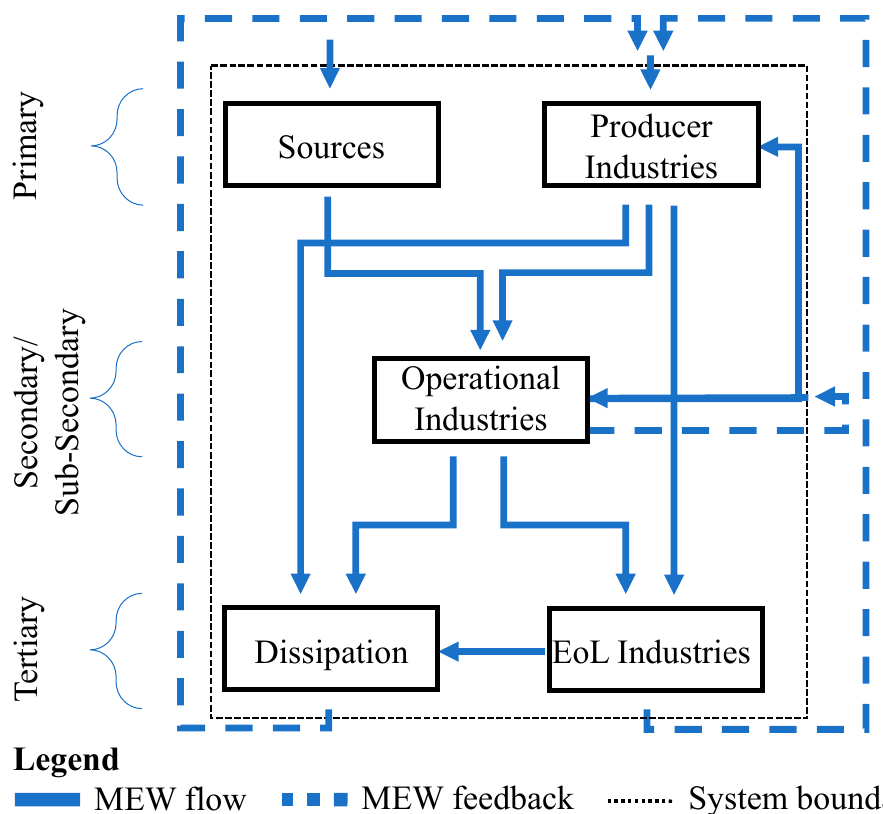
Figure 1. Network approach for the MEW interactions over the lifetime of PV technology. Three tiers in the life cycle include primary, secondary/sub-secondary, and tertiary, representing the ecological network or producers (Sources, Producer Industries), consumers (Operational Industries), and carnivores/detritivores (Dissipation, EoL Industries), respectively. Solid lines indicate MEW throughflow, dashed lines indicate MEW feedback and dotted lines show the life cycle assessment (LCA) of the system boundary.